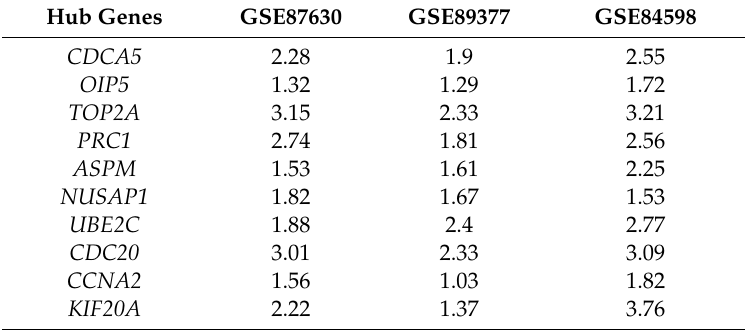
Figure 3. The protein-protein interaction network of the hub genes and the DEGs that directly interact with them. Each node represents a gene and each edge represents a direct interaction between two genes. The nodes filled with red in the center represent hub genes; the nodes filled with white represent the genes that interact directly with hub genes. Table 1. Log fold-change (logFC) of hub gene expression values in HCC samples compared with normal